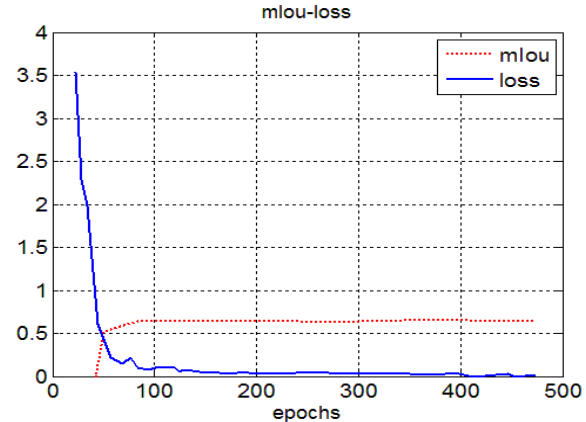
Figure 5. mIou-loss performance with different